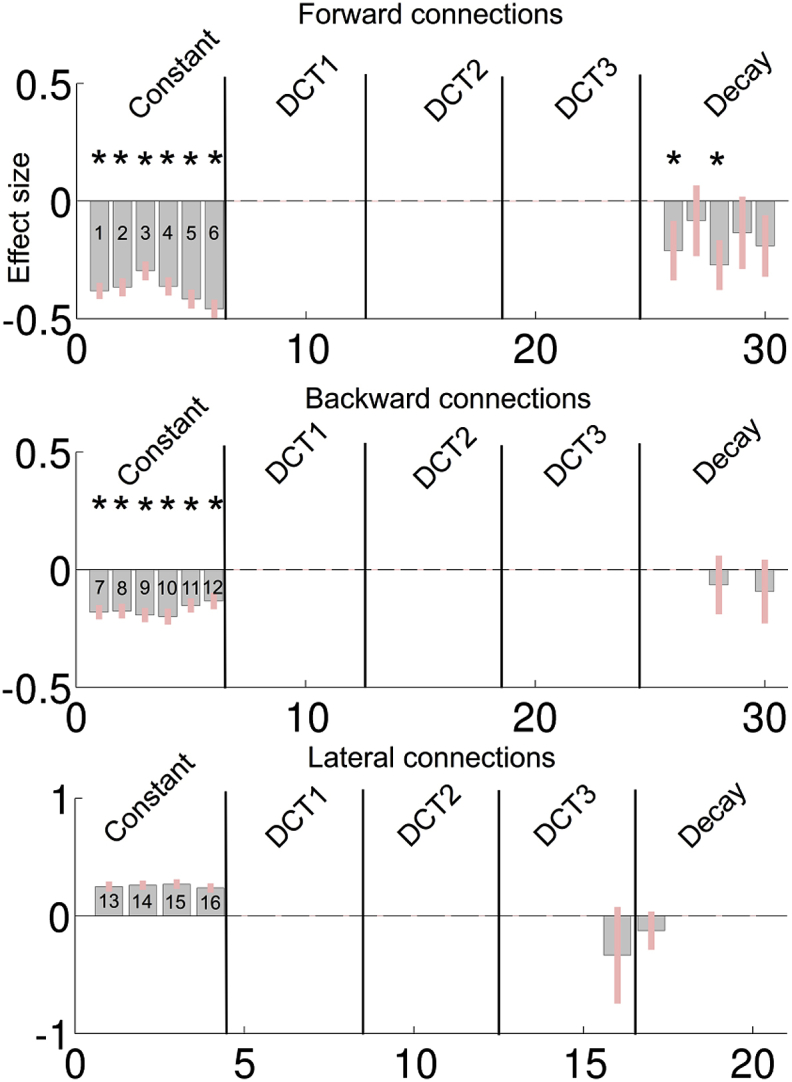
Same format as for Fig. 5 but now for the saliency network.